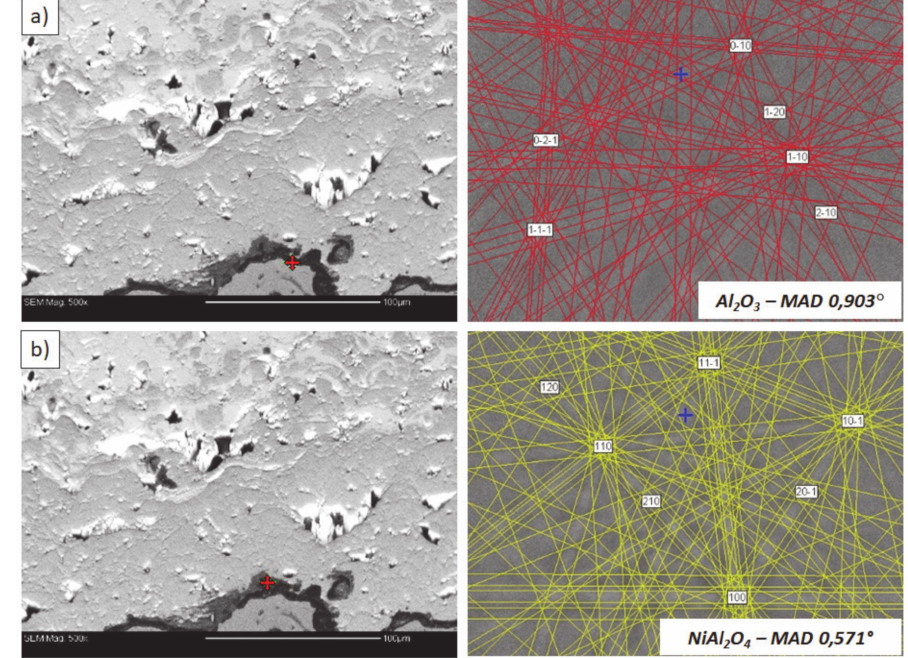
Figure 24. Analysis of phase composition in micro-areas of the TGO zone after 500 h of oxidation at a temperature of 1100 ◦ C by EBSD—8YSZ / TGO interface: ( a ) place of Al 2 O 3 detection, ( b ) place of NiAl 2 O 4